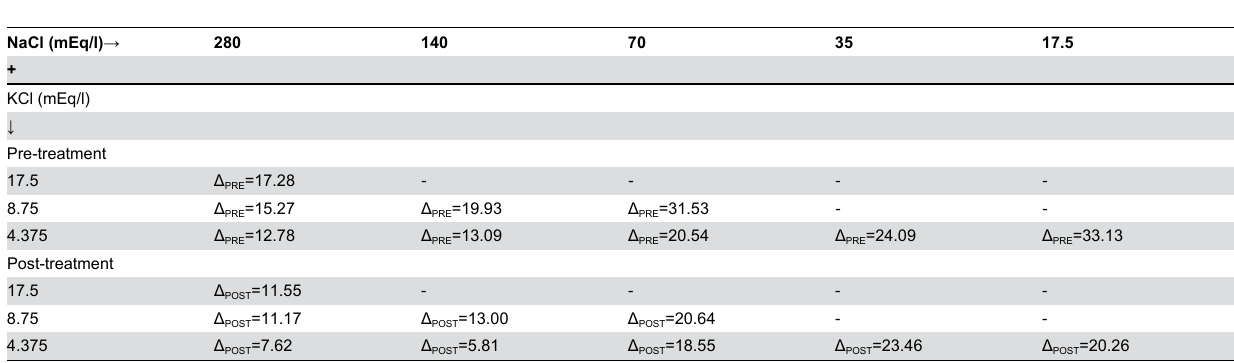
Table 2. Concentration of mixed samples (NaCl+KCl), and corresponding percentage difference in the conductivity (%) compared to the samples with NaCl alone at the same concentration, pre- and post-resin treatment (Δ respectively).